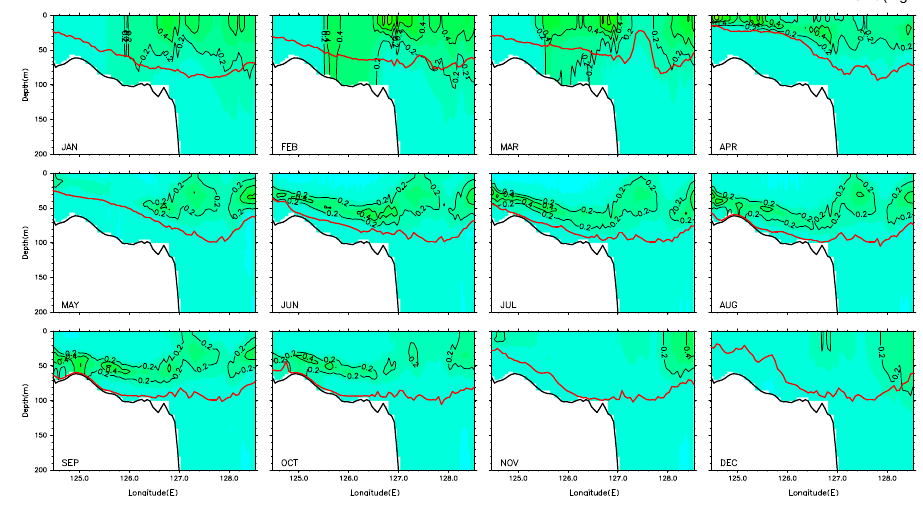
− 3 ). Fig.16 Fig. 16. The same as Fig. 15 but for chlorophyll a (mgm Table 3. Annual onshore fluxes of nutrients across the 200-m isobath in control and four sensitivity experiments. The positive flux is defined as onshore direction and the unit is kmols − 1 . “ctl” denotes the control experiment while “+10%”–“+40%” denote the sensitivity experiments, in which the concentration of oceanic nutrients in the Kuroshio water was artificially increased by 10–40%, respectively. The values in brackets denote the ratios of flux increases in sensitivity experiments to the initial flux in the control